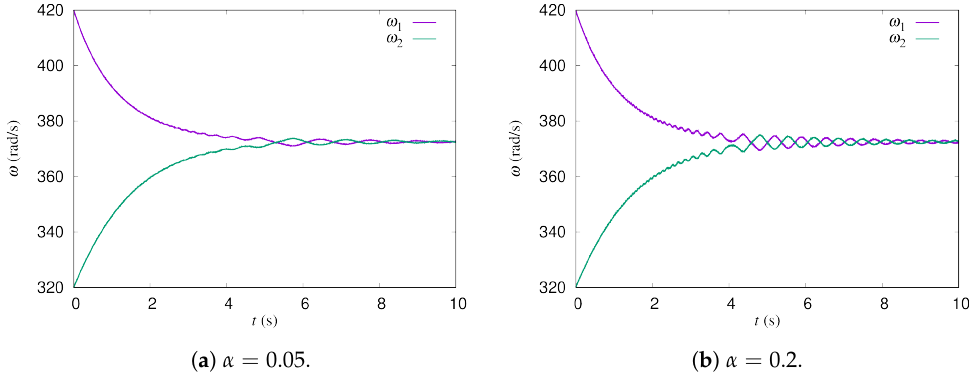
Figure 7. Time evolution of ω i for α = 0.05 and 0.2 in the CO layout with 10mm gap. Induced velocities are not taken into account.